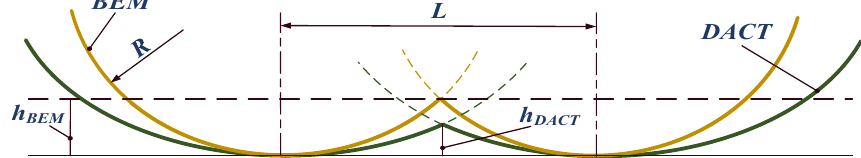
Figure 9. Comparison schematic diagram of cutting scallop